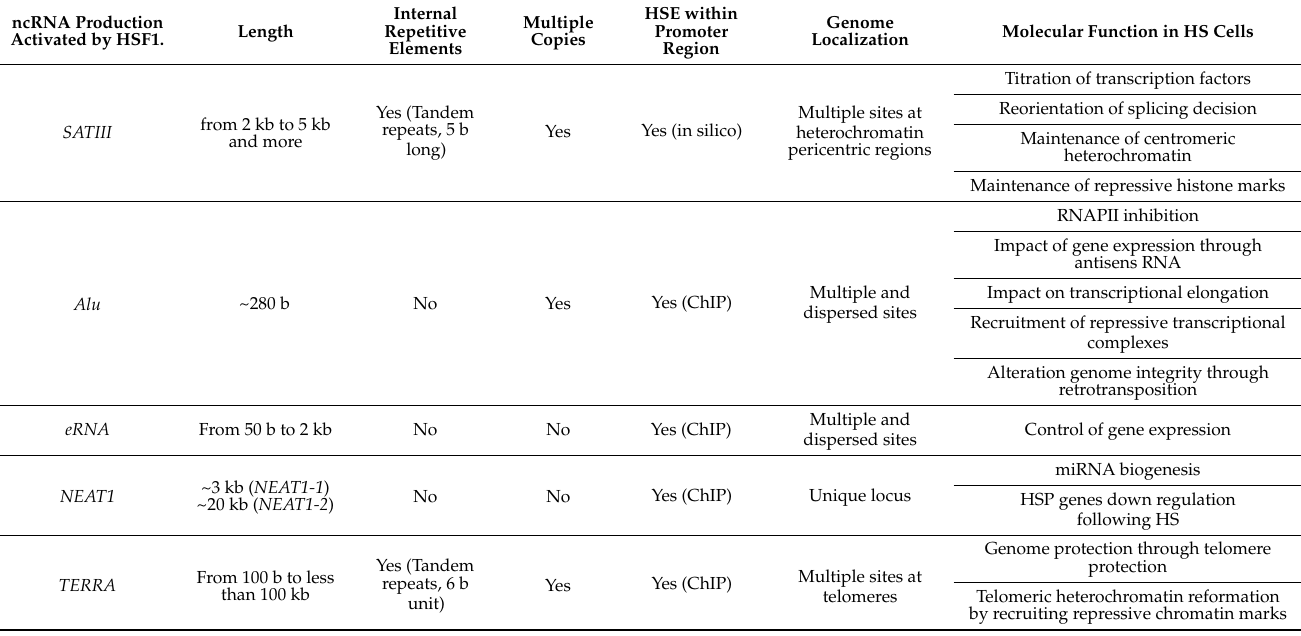
Table 1. List of ncRNAs that have their production activated by HSF1-induced transcription. Note: For genes and RNAs we follow the recommendation of Seal and coauthors